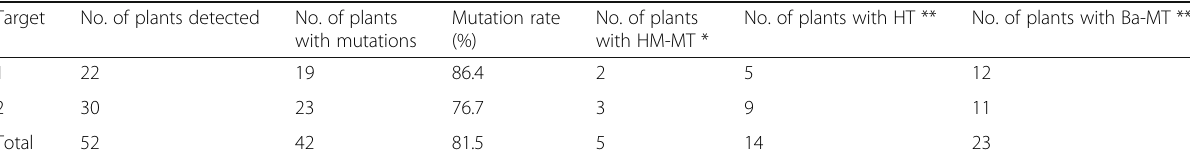
Table 2 Information of T 0 plants found with CRISPR/Cas9-generated mutations in the target sequences Target